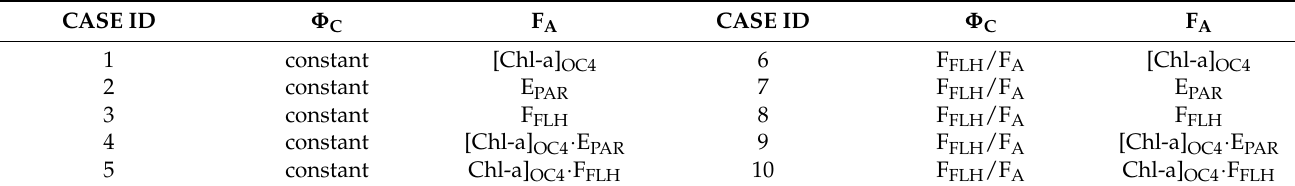
Table 1. List of all the F C-RS parametrizations investigated and tested in this